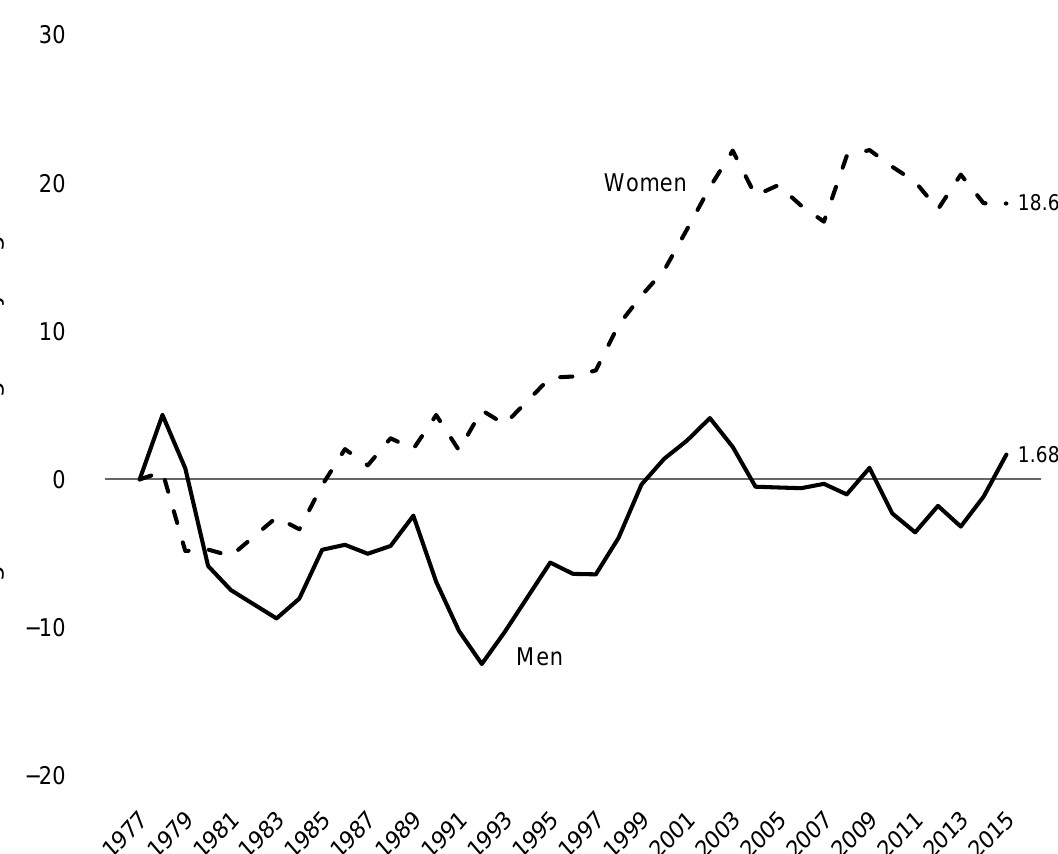
Figure 1: Trends in nonunion median weekly wages,